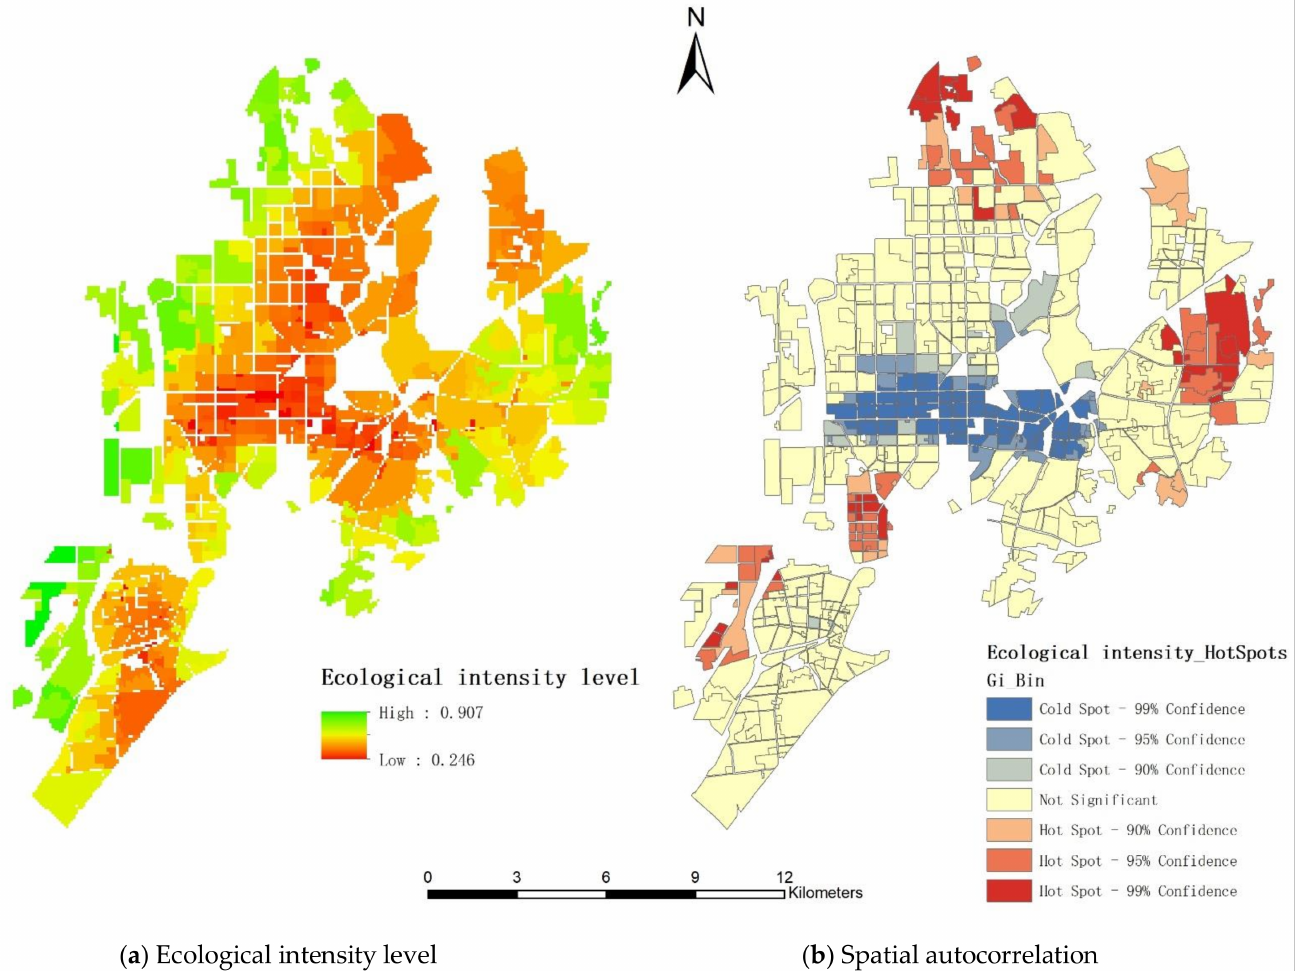
Figure 4. Evaluation results and spatial distribution of ecological intensity of